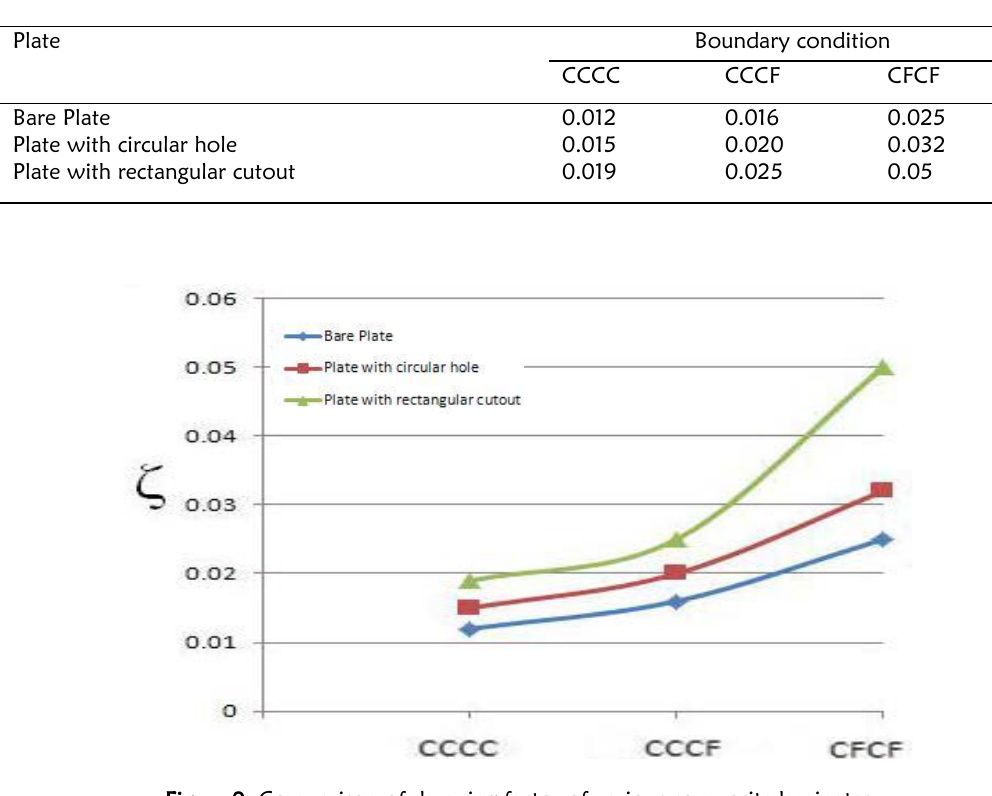
Table 3: Damping Ratio from Experiment